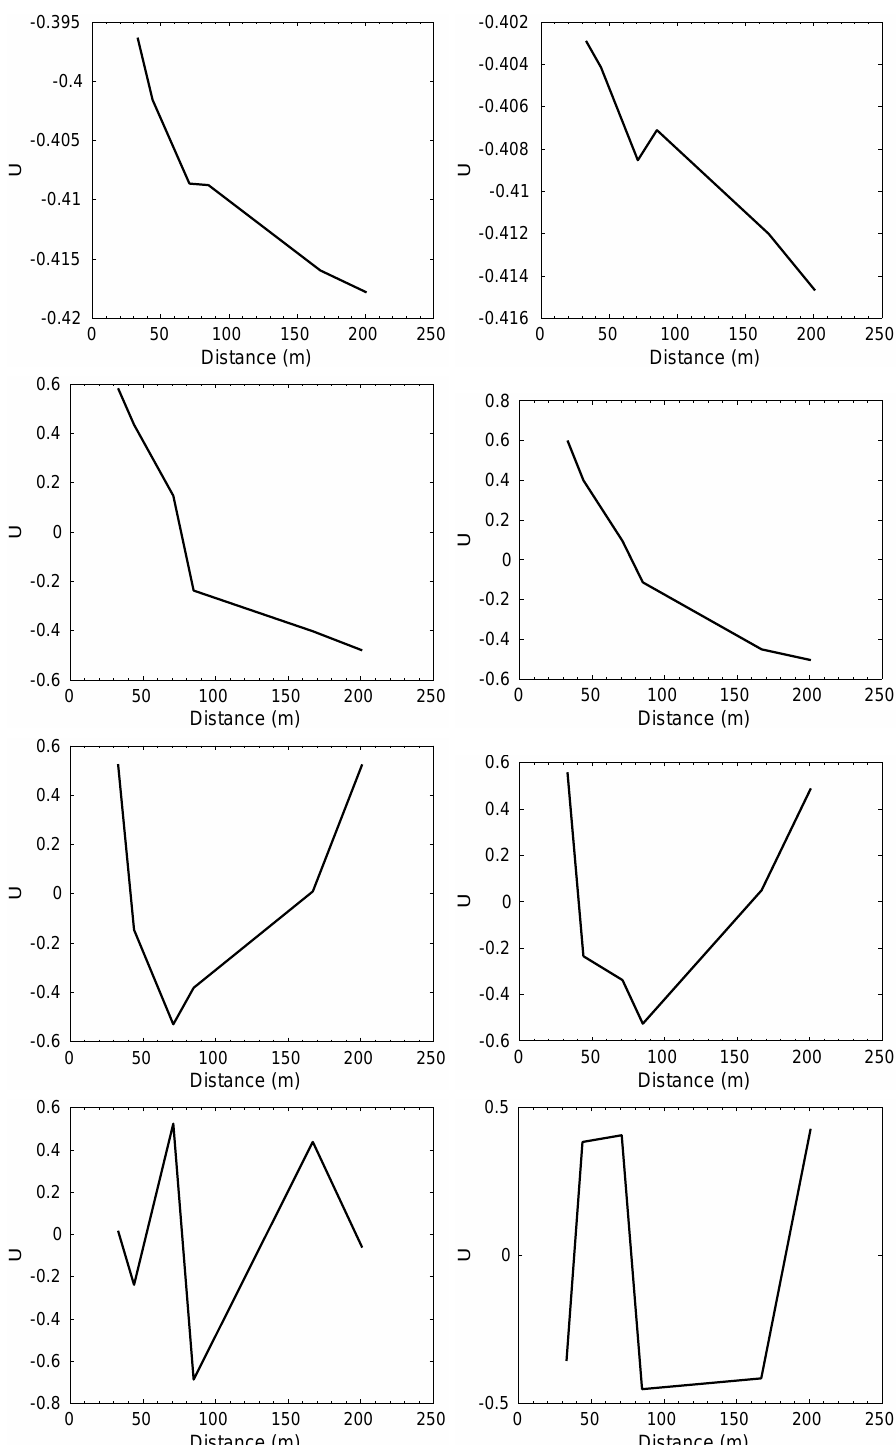
Figure 10. SVD modes calculated in the data sets obtained in the left ( left ) and right ( right ) sides of the wind turbines. From top to bottom: modes 1 to